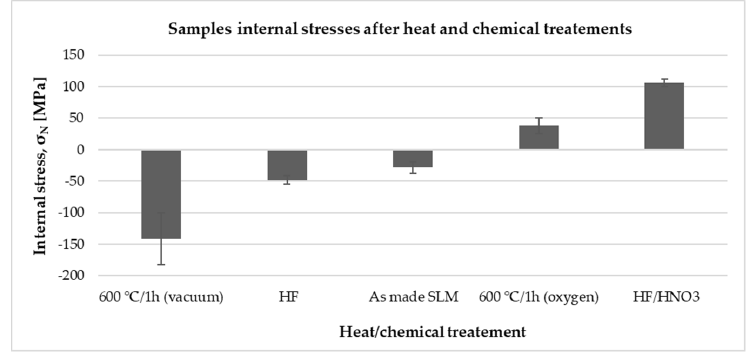
Figure 4. Samples internal stresses after the heat and chemical treatments.